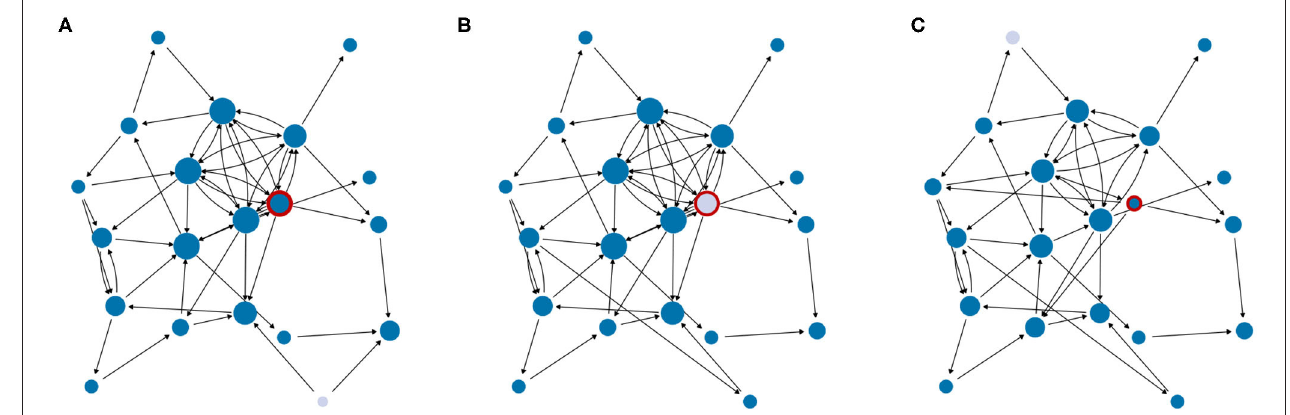
FIGURE 5 | Network evolution with a targeted intervention of firm 1 (always circled in red). Firms with x stat i (0) < x thr (condition A) (marked in light blue) will leave the network. (A) T = 250, (B) T = 250, and (C) T = 252.